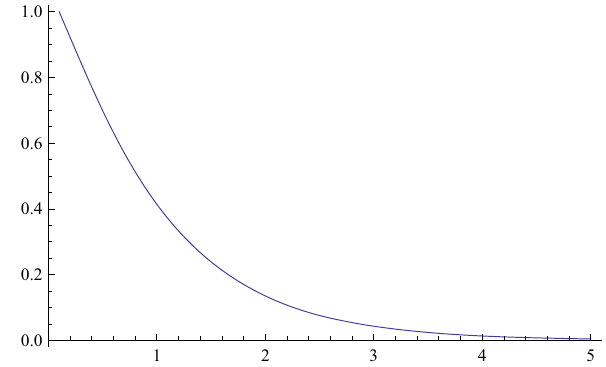
Fig. 1 Numerical plot of ϕ( t ) in Eq. (4.3) from t = 0 to t = 5 with ϕ( 0 ) = 1, and κ = V = 1 0 in Eq. (2.10). We could equally define a spin–spin effective equation of state related to u ij , which we omit here for sim-